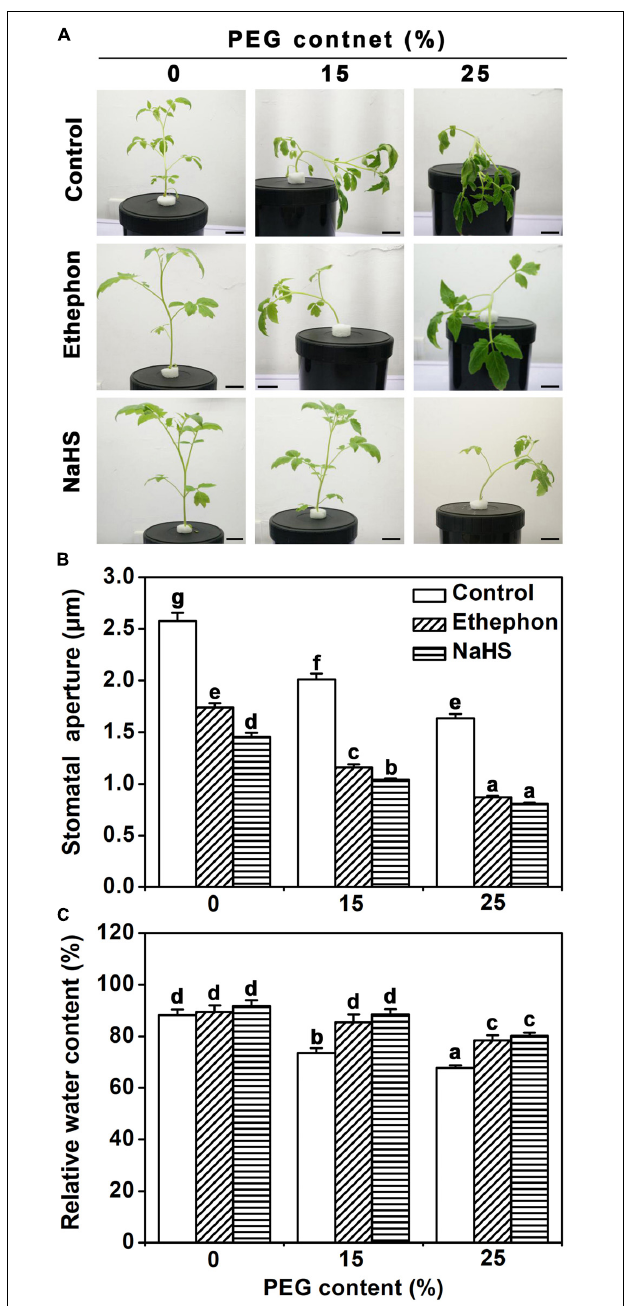
FIGURE 1 | Biological phenotype assays. (A) Photographs of tomato seedlings. Two-week-old tomato seedlings were supplied with between 0 and 25% PEG, 200 µ M NaHS and 1.0 g/L ethephon for 3 days, and then the phenotype was observed (Bar = 2 cm). (B) Two-week-old tomato seedlings were supplied with between 0 and 25% PEG, 200 µ M NaHS and 1.0 g/L ethephon for 6 h, and then the stomatal aperture was measured. The data are mean values ± SE ( n = 50). (C) Two-week-old tomato seedlings were supplied with between 0 and 25% PEG, 200 µ M NaHS and 1.0 g/L ethephon for 6 h, and then relative water content (RWC) was measured. Mean values ± SE are calculated from three replicates. Within each set of experiments, bars with different letters are significant different (Duncan’s multiple range tests, P <